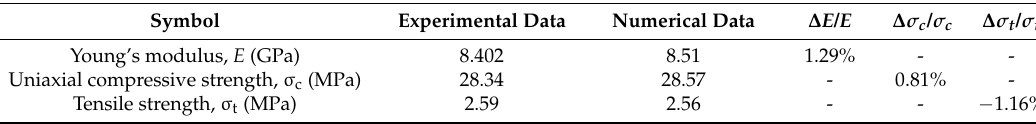
Figure 4. Simulation of uniaxial compression of a sample compared with experimental observations by Chen et al. [11]. Table 1. Comparison of experimental data and numerical